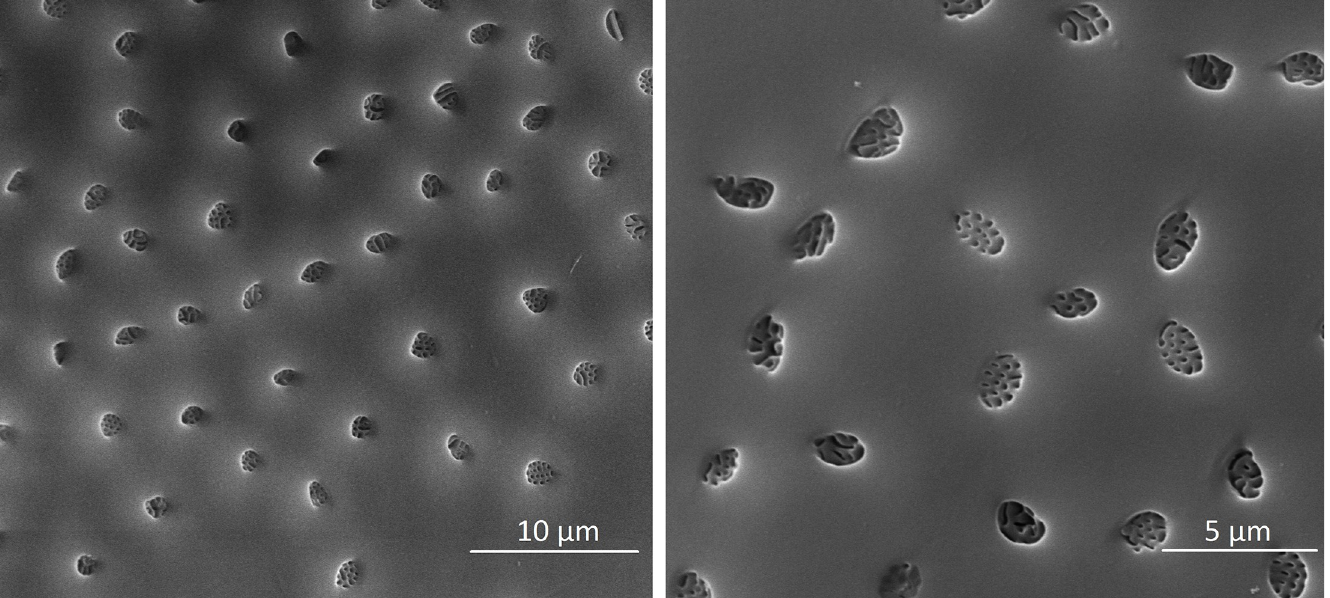
PLOS ONE | https://doi.org/10.1371/journal.pone.0210524 January 11,